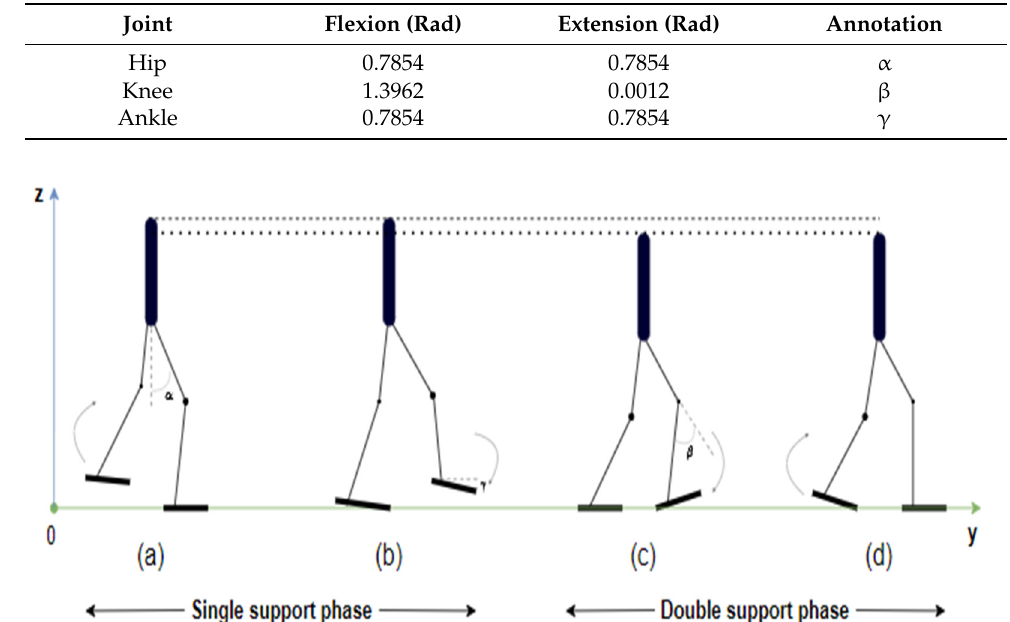
Table 2. Limiting rotation angle and annotation of joints.